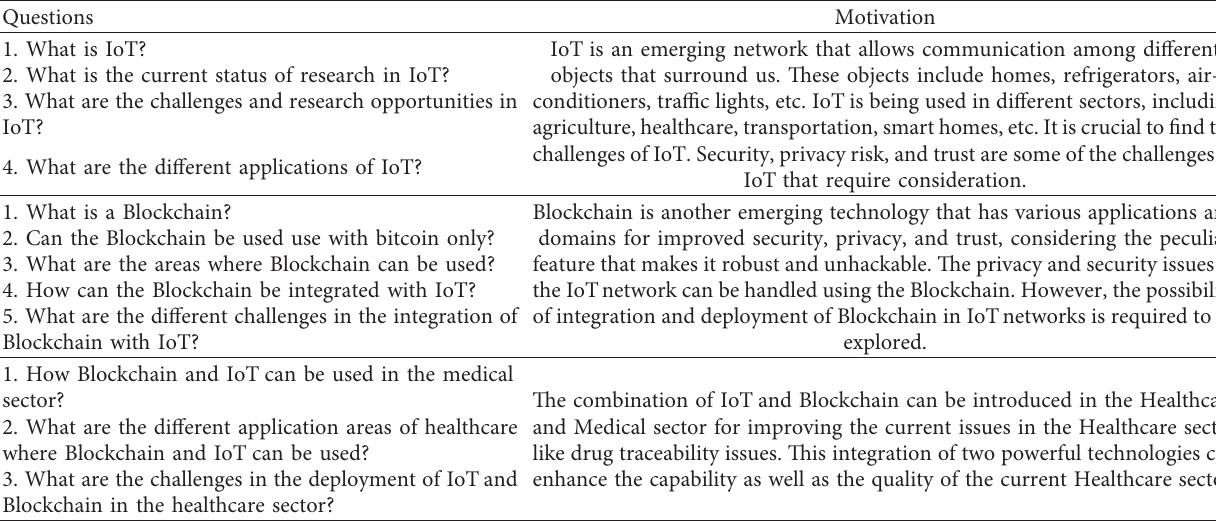
Table 1: Research questionnaire and motivation.